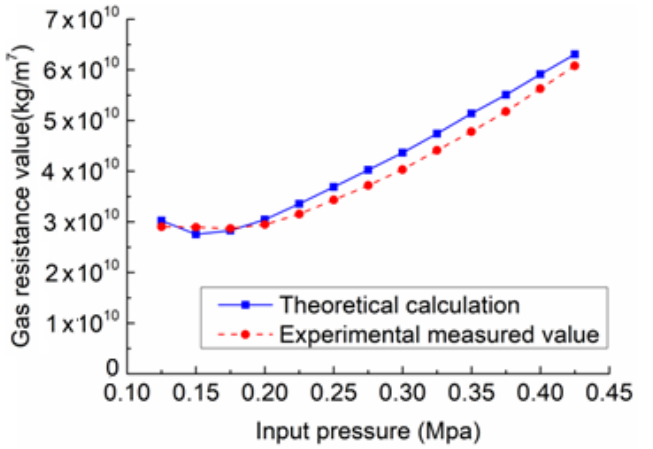
Figure 8. Comparison curve between the theoretical and experimental values of the gas resistance and input pressure of the tube with an inner diameter of 4 mm and tube of 0.5 m.